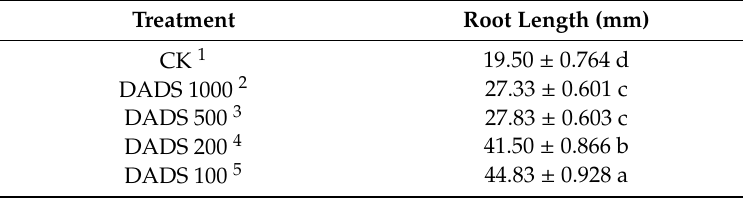
Table 4. E ff ects of di ff erent concentrations of DADS on tobacco root